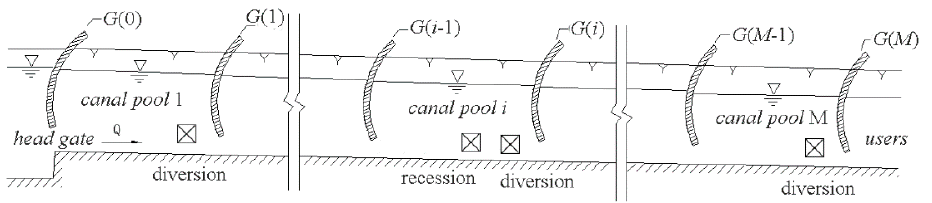
Figure 3. Sketches of a typical canal